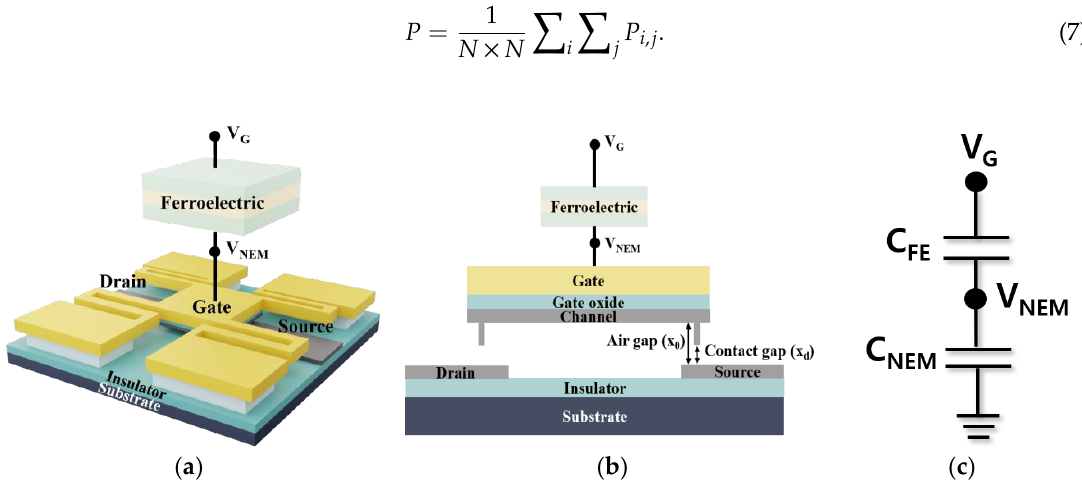
Figure 1. ( a ) Isometric view of negative capacitance (NC) + nanoelectromechanical (NEM) relay. Note that NEM relay is connected in series to ferroelectric capacitor; ( b ) cross-sectional view along the channel of NC + NEM relay when it is turned off; ( c ) capacitive circuit schematic of NC + NEM relay.